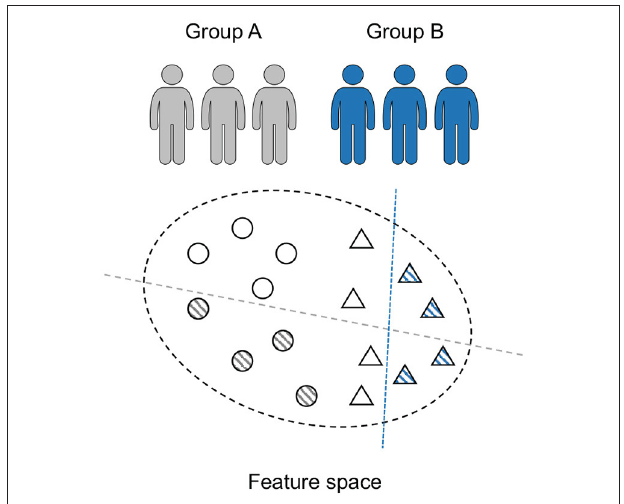
FIGURE 2 | Seizure prediction is a patient-specific problem. The discriminative models (dashed line) of various individuals (circle and triangle) differ